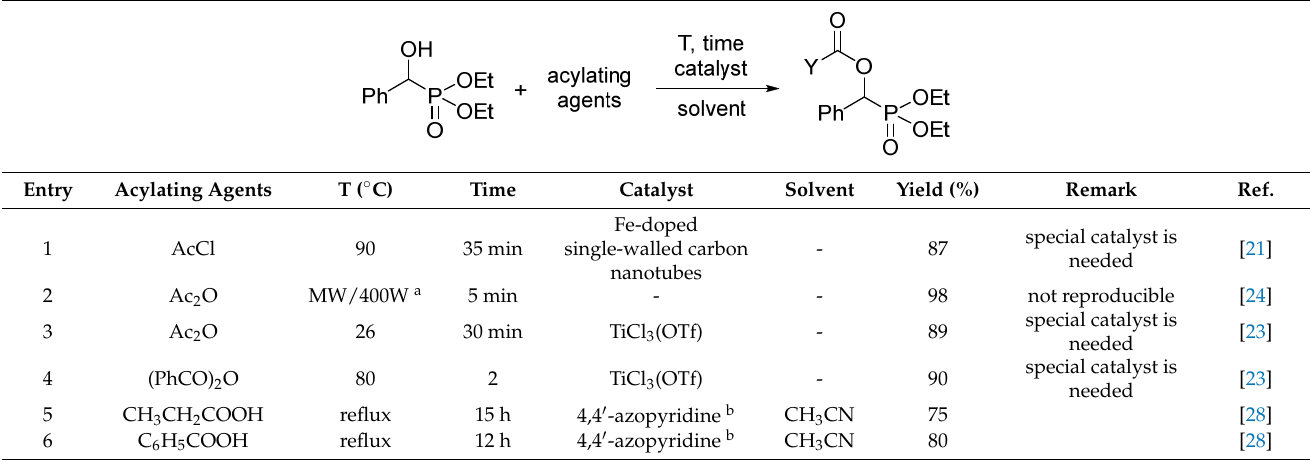
Table 1. Different ways for the acylation of diethyl- α -hydroxy-benzylphosphonate.